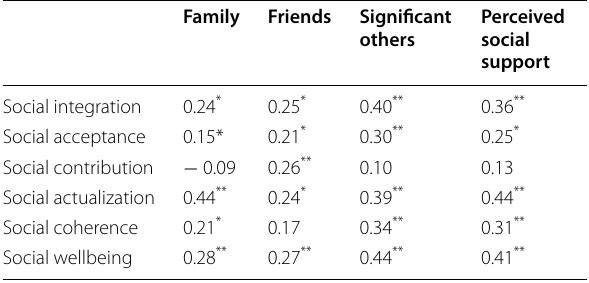
Table 1 Inter correlation matrix: perceived social